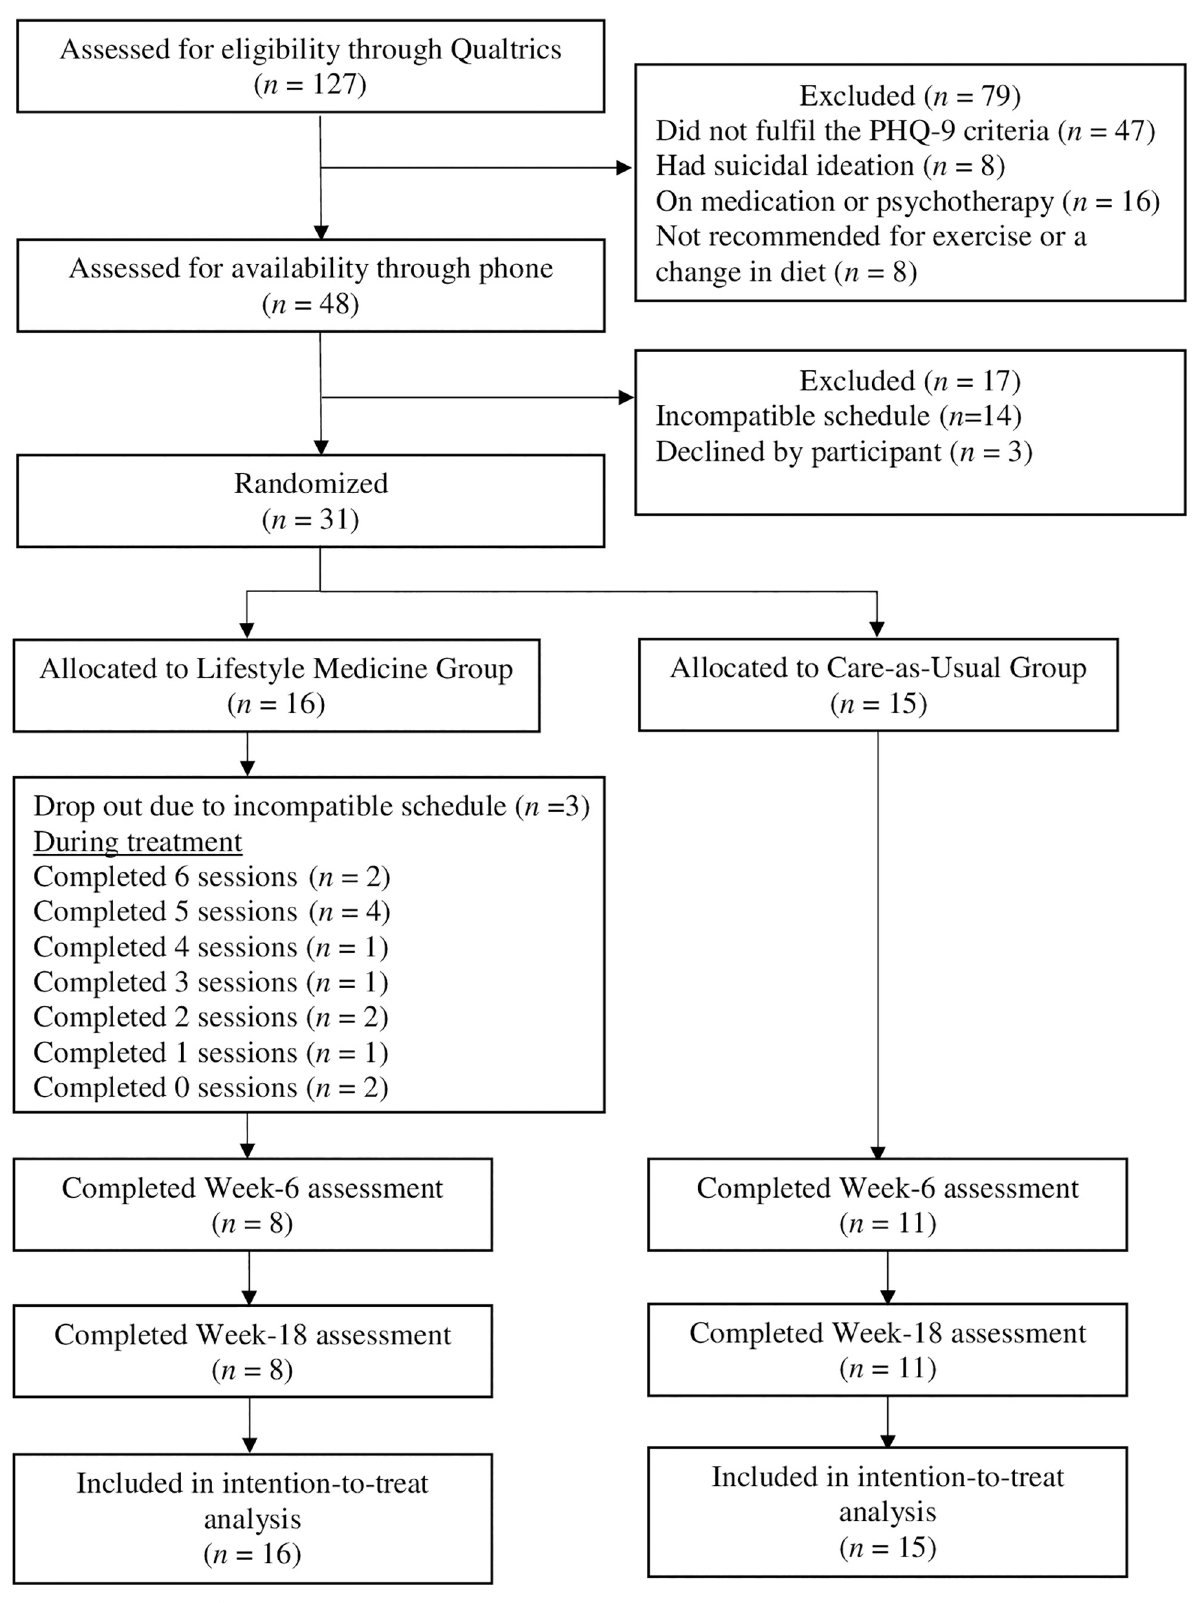
Fig 1. CONSORT study flowchart.